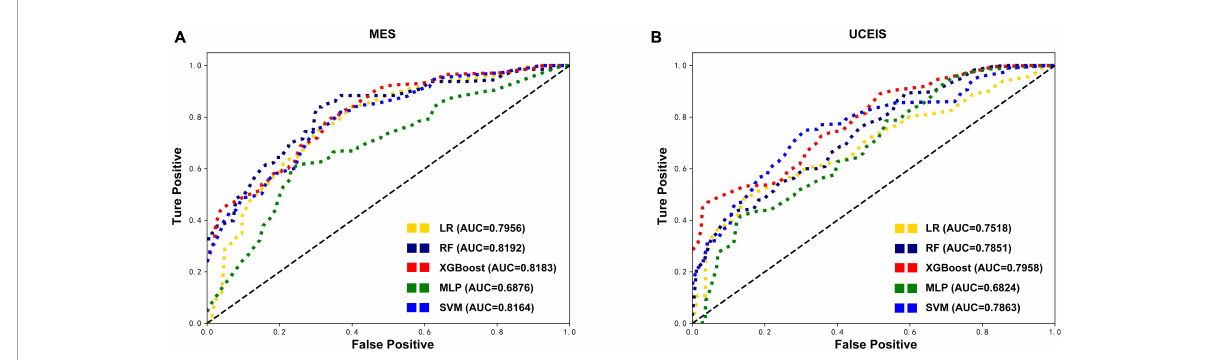
FIGURE3 Comparison of the oversampling datasets-based models’ performance. After the synthetic minority oversampling technique (SMOTE) method, receiver operating characteristic curves show the endoscopic disease activity predictive performance of five algorithms based on the mayo endoscopic subscore (MES) (A) and ulcerative colitis endoscopic index of severity (UCEIS) (B) in test datasets. LR, logistic regression; RF, random forests; XGBoost, extreme gradient boost; MLP, multilayer perceptron; SVM, support vector machine; AUC, area under the receiver-operating characteristic curve.